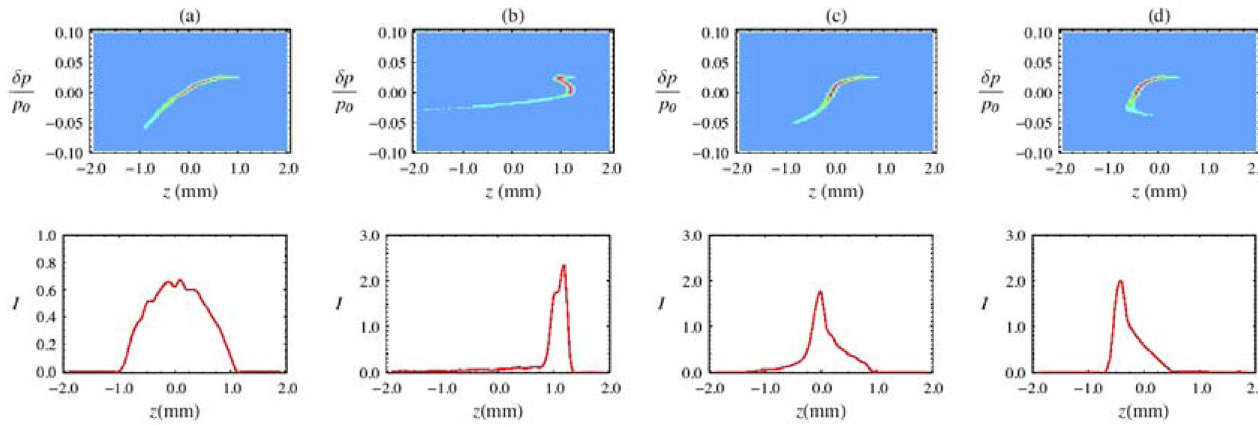
FIG. 4. (Color) Plots of the z trace space and current profiles from PARMELA and ELEGANT simulations of the ORION dogleg section showing (a) the beam at the entrance, and the same beam at the end (b) without sextupole correction and (c) with sextupole correction. In (d) symmetrically placed octupoles are inserted for third-order correction. Beam currents are in arbitrary units, but the scale is the same on all